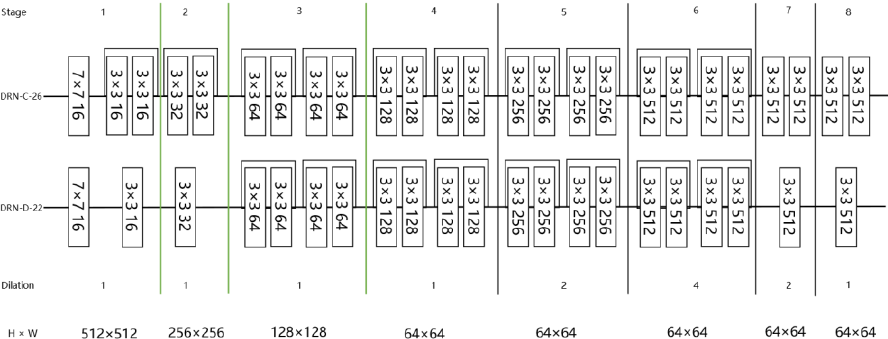
Figure 2. A comparison of DRN-D-22 and DRN-C-26. The DRN is divided into eight stages, and each stage outputs identically-sized feature maps and uses the same expansion coefficient. Each rectangle in the figure represents a Conv-BN-ReLU combination. The number in the rectangle indicates the size of the convolution kernel and the number of output channels. H × W is the height and width of the feature map, and the green lines represent downsampling by a stride of two.